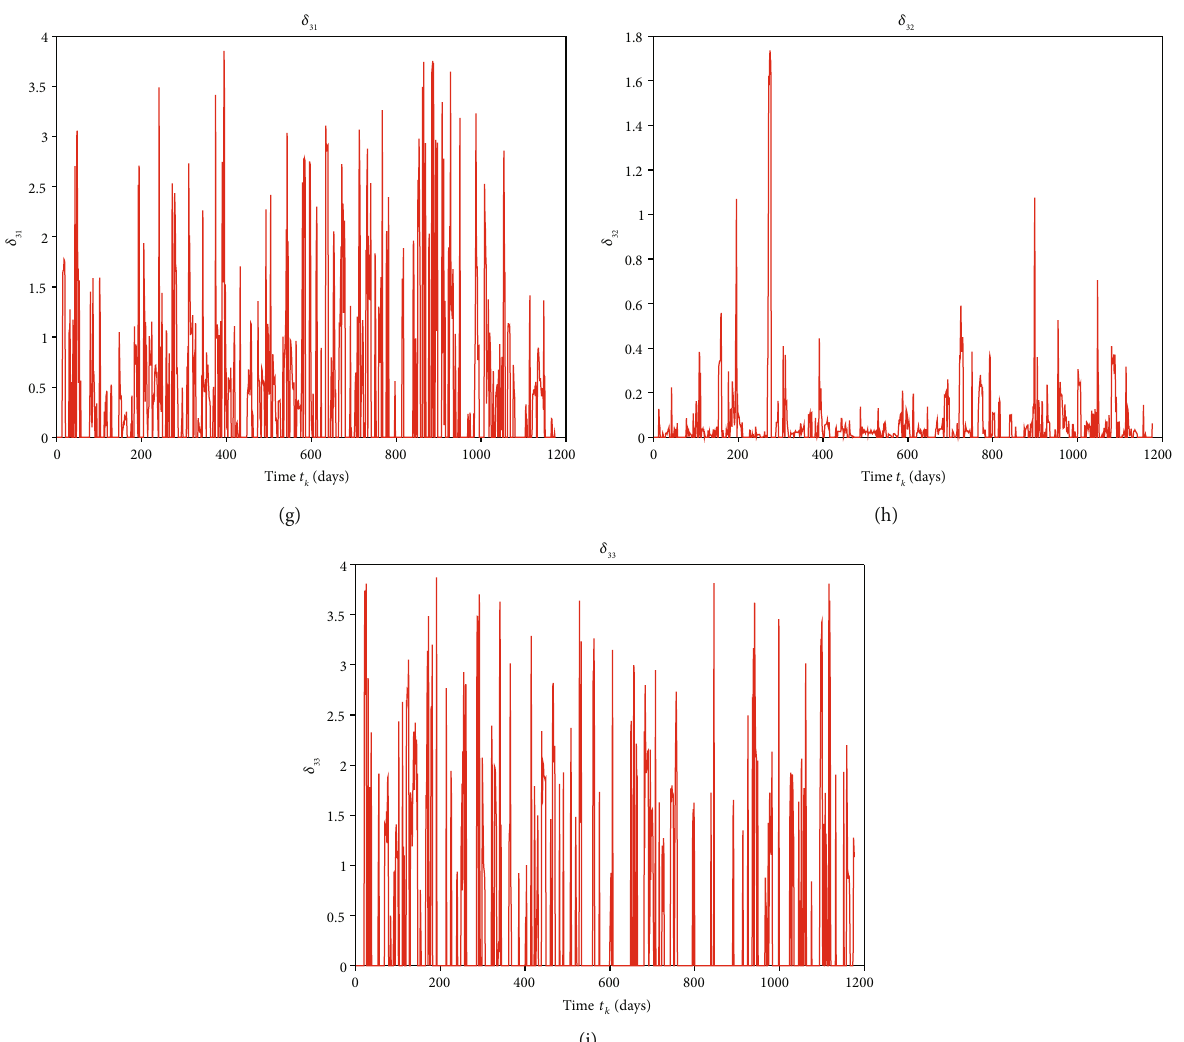
Figure 10: The graph of interaction coe ffi cients δ and δ